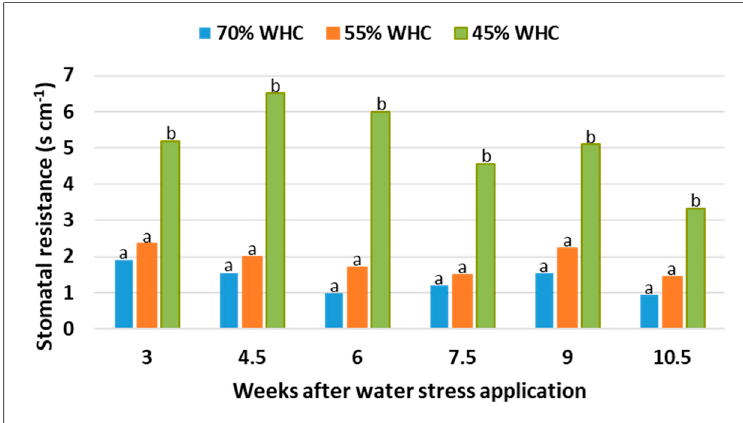
Figure 4. E ff ect of water stress on the leaf stomatal resistance of castor plants. Di ff erent letters show Figure 4. Effect of water stress on the leaf stomatal resistance of castor plants. Different letters show statistically significant di ff erences (ANOVA, Duncan test, p < 0.05, n = statistically significant differences (ANOVA, Duncan test, p < 0.05, n = 5).